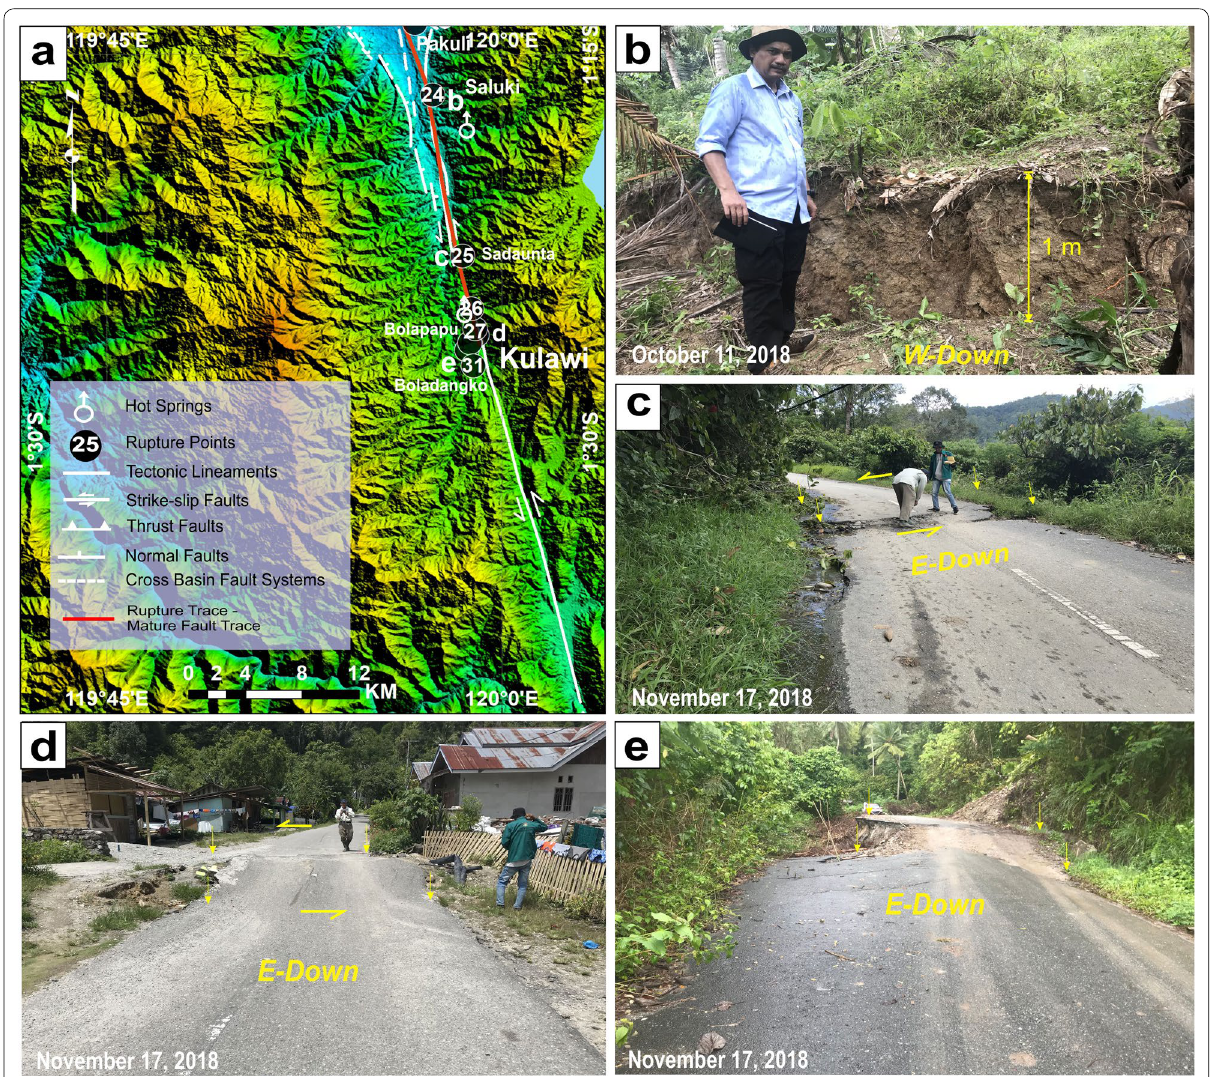
Fig. 5 a Site map of surface rupture, ground fissures, hot springs in the Sigi valley. Structural lineaments are drawn after Watkinson and Hall (2017). The base map is a 30 m DEM-SRTM (USGS). Surface rupture in b Saluki village, c Laone, d Bolapapu 1 village, and e Boladangko